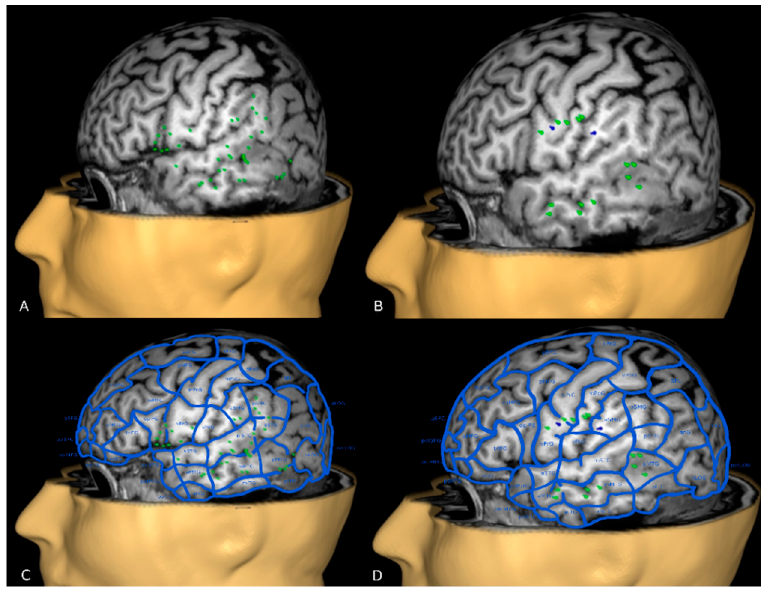
Figure 2. ( A ) Romanian rnTMS mapping (green spots: performance errors) and ( B ) Italian rnTMS mapping (green spots: performance errors, blue spots: semantic errors). ( C , D ) show the anatomical distribution of all errors according to the parcellization system area described by Corina et al., in Romanian and Italian,